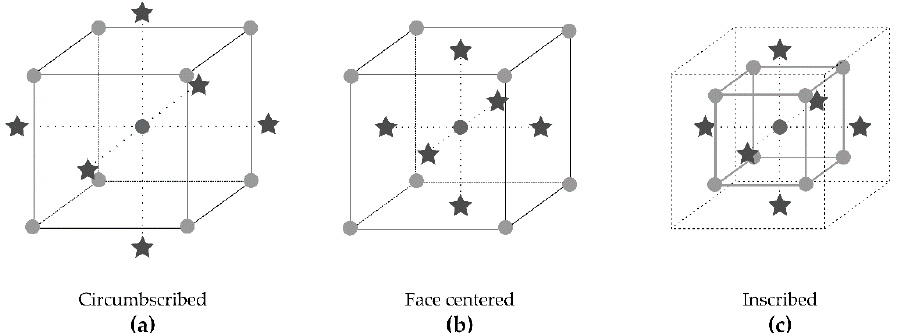
Figure 7. Graphical representation of the design space in three different typologies of the central composite designs s(CCDs). In circumscribed designs ( a ), the star points are set at an alpha distance from the centre point, which leads to new extreme high and low values for all studied factors. If alpha = ± 1, star points fall on the centre of each face of the factorial space and a face-centred CCD is obtained ( b ). If the extremes values determined by a circumscribed design cannot be studied, an inscribed CCD ( c ) considers alpha points as limit values (alpha = ± 1), and the initial factor settings are scaled down to fit within this new experimental domain.